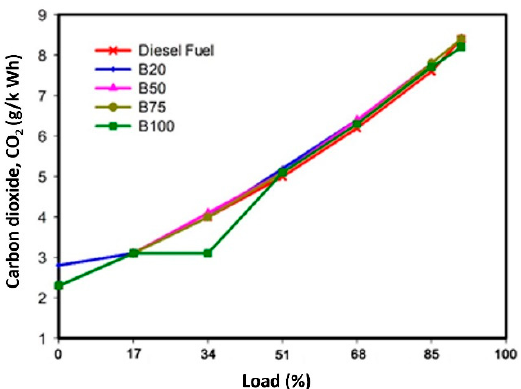
Figure 11. Variations of CO 2 with engine load for diesel, sheep fat biodiesel (B100) and biodiesel blends (B20, B50 and B75)